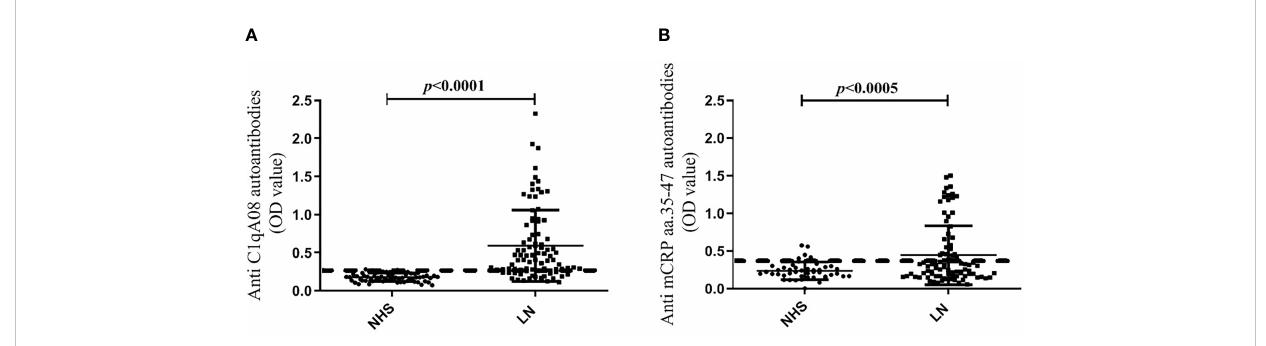
FIGURE 1 (A) Comparisons of levels of anti-A08 antibodies in LN and healthy blood donors. (B) Comparisons of levels of anti-mCRP a.a.35-47 antibodies in LN and healthy blood